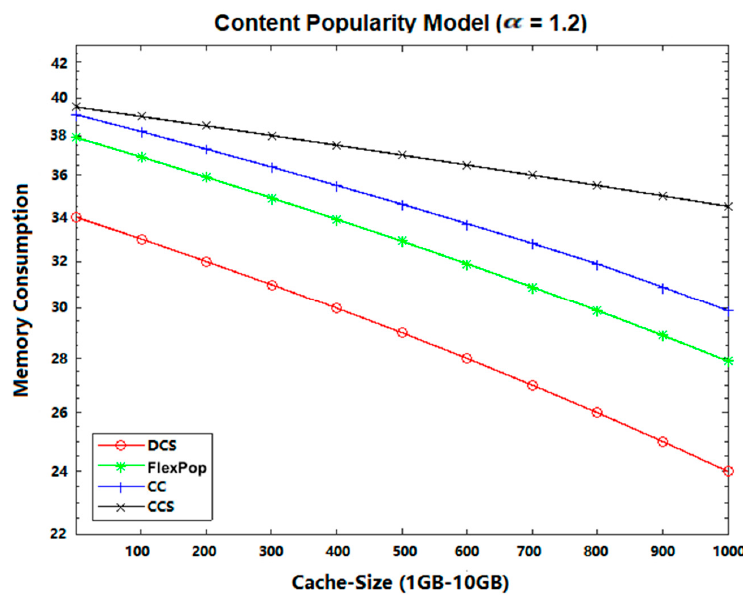
Figure 8. Memory Consumption on GEANT Topology with VoD